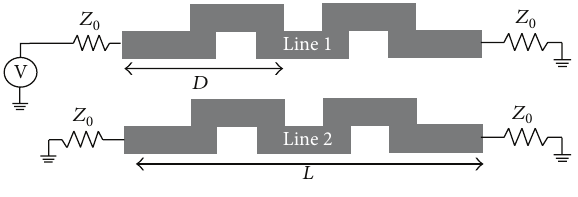
Figure 4: Parallel serpentine microstriplines.